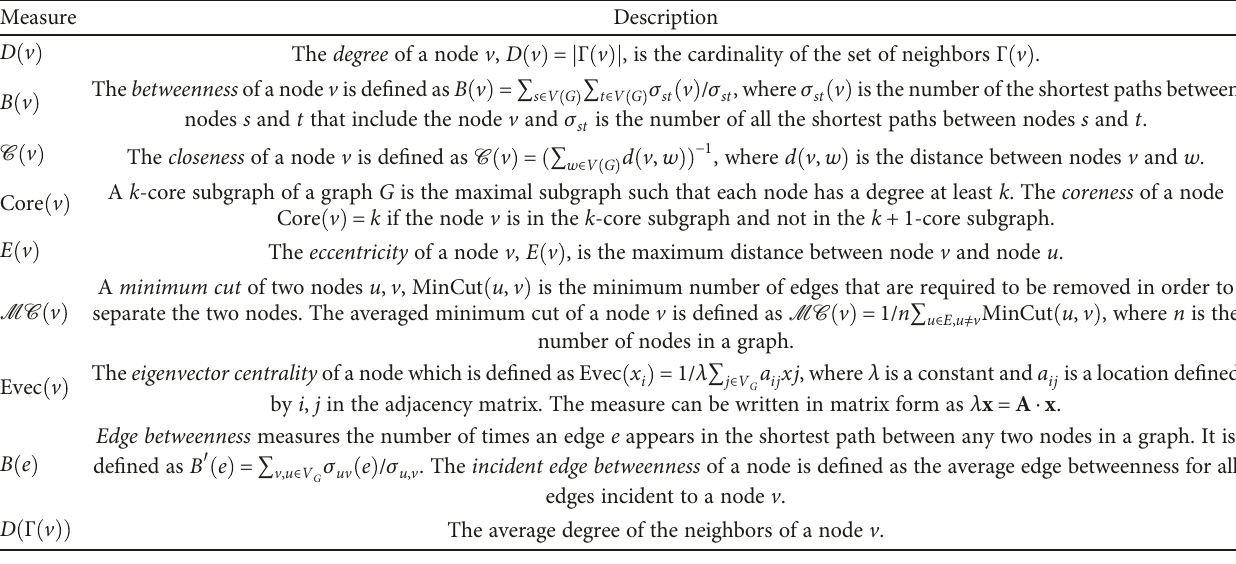
Table 1: De fi nitions of the network-based measures used in this